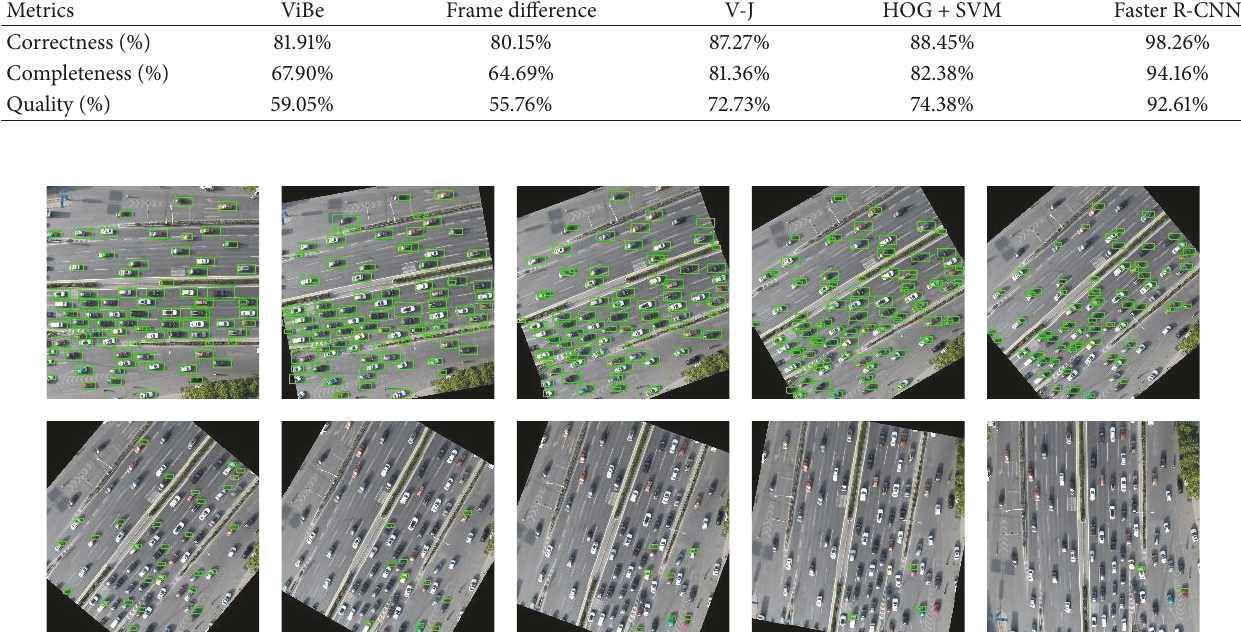
Figure 7: Car detection by HOG + SVM using image dataset which contain cars orientated in different orientations (0 ∘ , 10 ∘ , 20 ∘ , 30 ∘ , 40 ∘ , 50 ∘ , 60 ∘ , 70 ∘ , 80 ∘ , and 90 ∘ ).